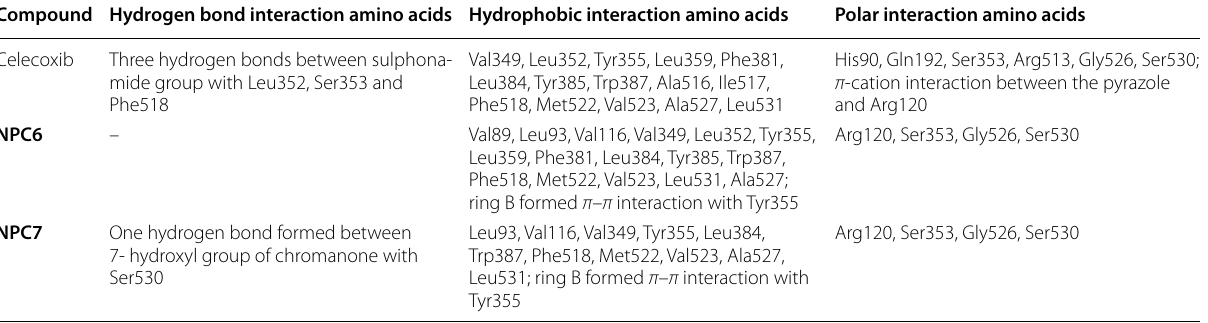
Table 4 Binding interaction analysis of the active compounds in COX-2 active site Compound Hydrogen bond interaction amino acids Hydrophobic interaction amino acids Polar interaction amino acids Celecoxib